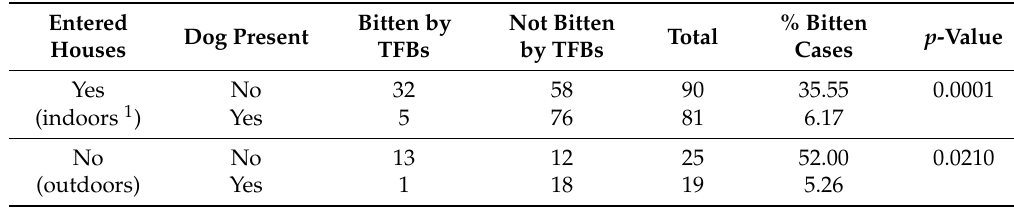
Table 2. The risk probability of human bitten by rabid TFB, n = 215.